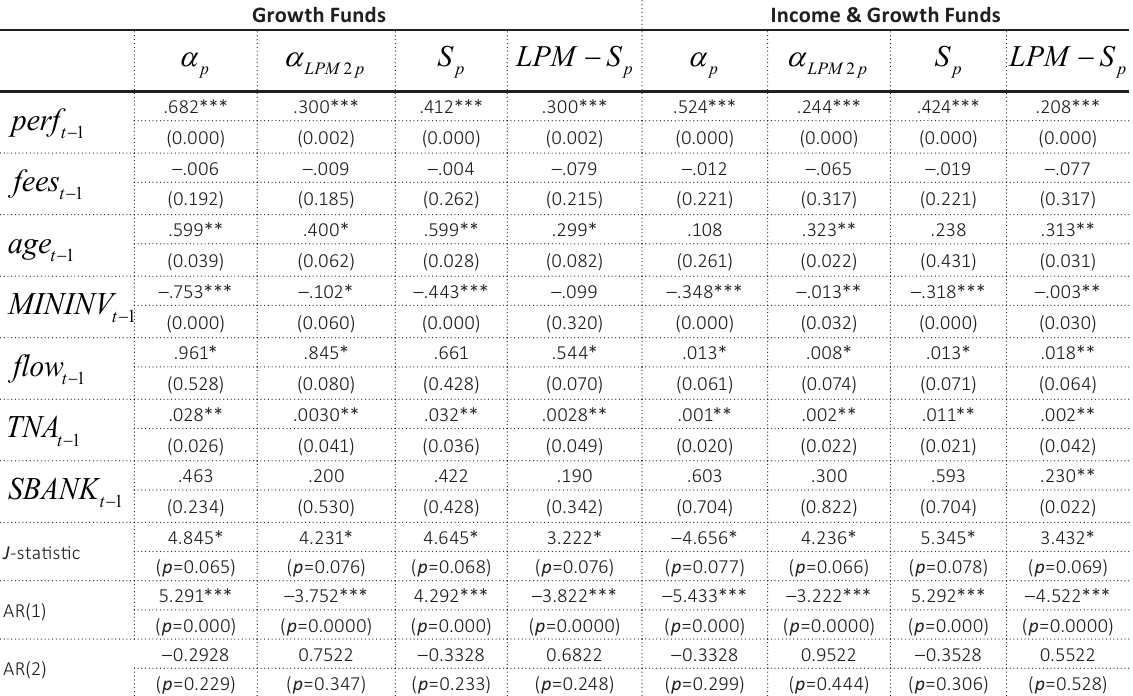
Table 5. Influence of fund-specific factors on future performance for the two subsamples: